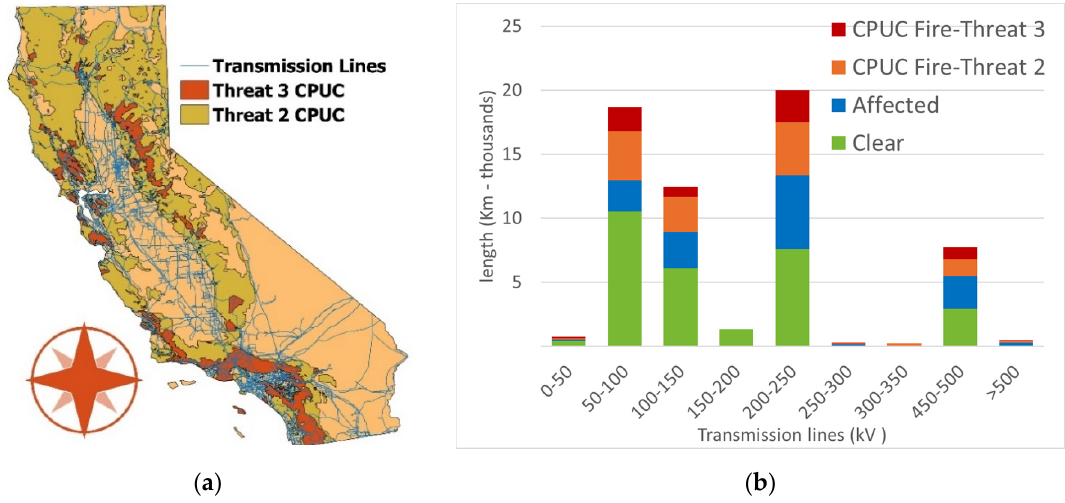
Figure 5. ( a ) Map overlaying transmission lines with affected CPUC Threat 2 and 3 areas. ( b ) Stacked column bar chart with transmission lines (in thousands of km) affected by CPUC Threat 2 and 3 areas.